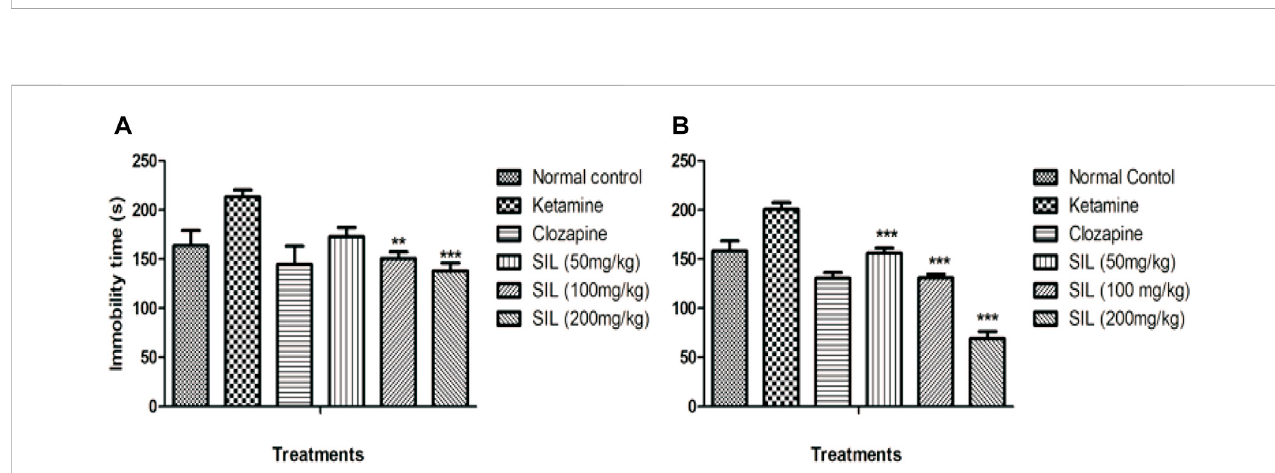
FIGURE 4 Effect of SIL on ketamine-induced hyperlocomotion in preventive (A) and curative (B) protocols. Values are expressed as mean ± SEM; n = 10, *** p < 0.001 as compared to the ketamine group.